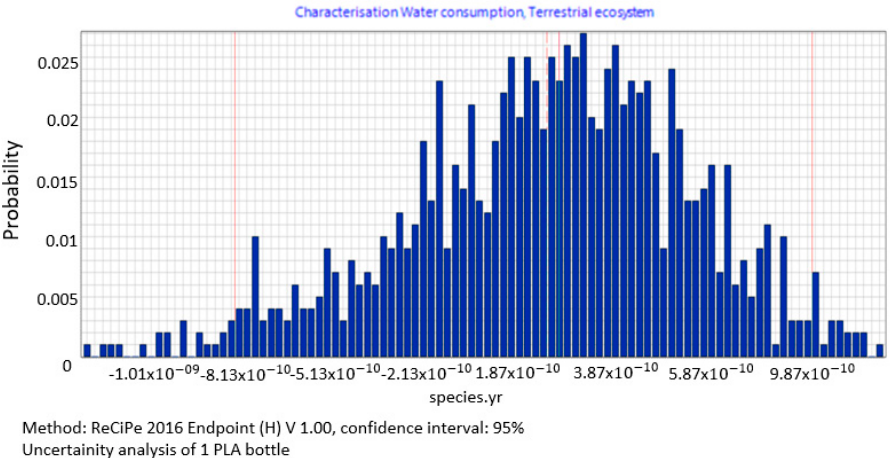
Figure 13. Results of the uncertainty analysis for the category of water consumption, terrestrial ecosystems and its impact on the ecosystem quality.